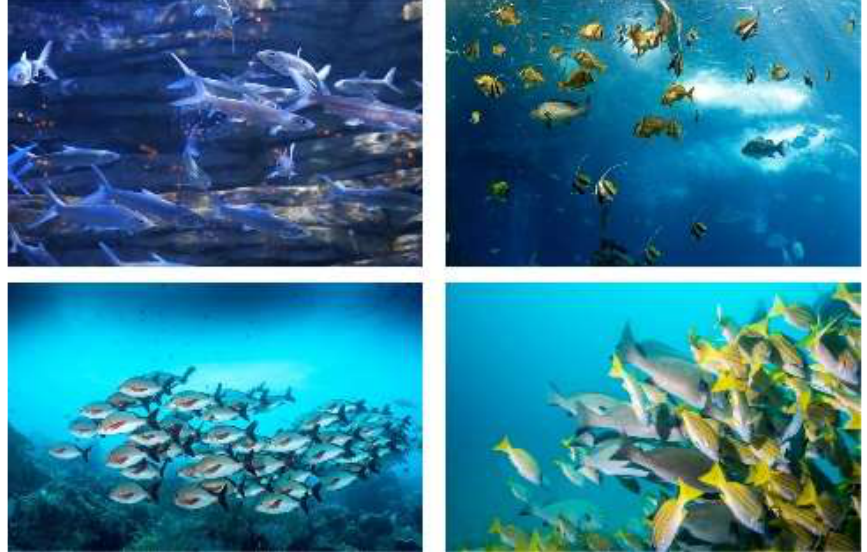
Figure 1. Individual fish images taken from underwater. They contain extreme occlusion between individuals, chromatic aberration variation, a complex undersea environment and a high degree of visual similarity among fish species.